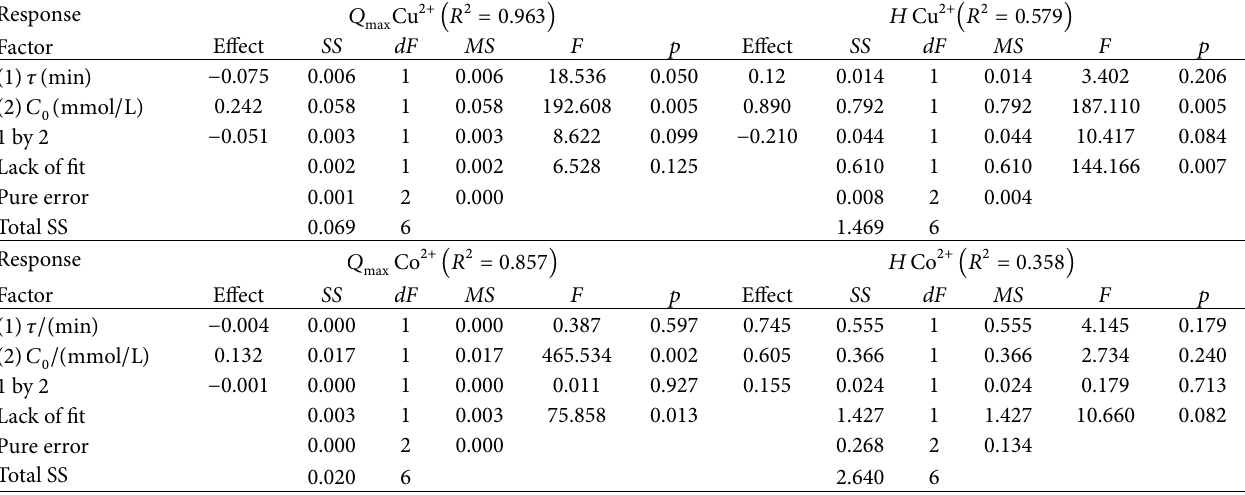
Table 6: ANOVA for 2 2 experimental design for adsorption of Cu 2+ and Co 2+ on SBox in a fixed-bed column adsorption at 25°C. Response